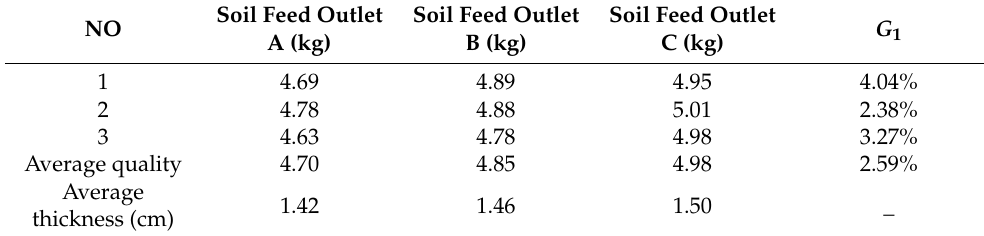
Table 11. Field experiment design and data.